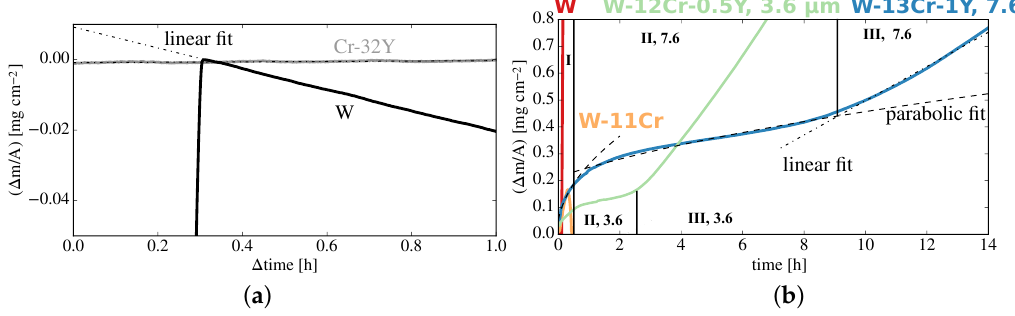
Figure 3. Mass change of thin films as a function of time. The samples were exposed to a temperature of 1273K at 20kPa O 2 and 80kPa Ar partial pressure. ( a ) shows CrY-oxide and a W-oxide; ( b ) Shows smart alloys. Oxidation stages I-III are labeled, the numbers 3.6 and 7.6 refer to the sample thickness of 3.6µm and 7.6µm,